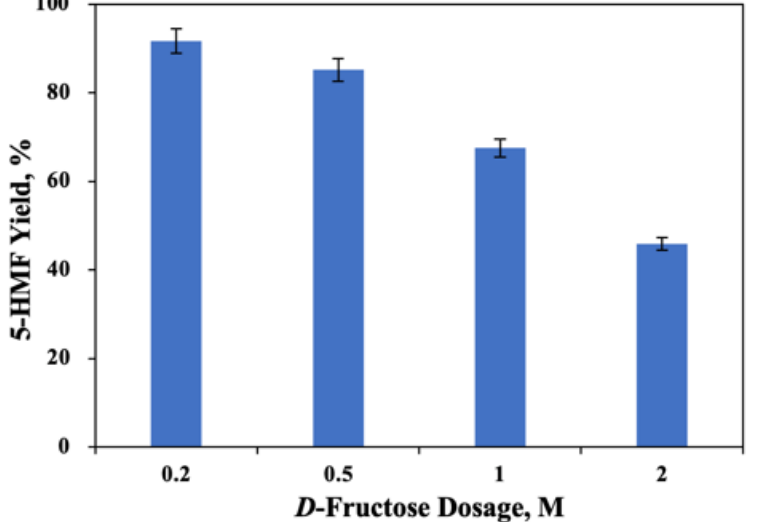
Figure 4. Effect of initial D -fructose dose (0.2–2 M) on the 5-HMF formation [B:Gly 20 wt%, SG(SiO 2 ) 3 wt%, 150 °C, 1.5